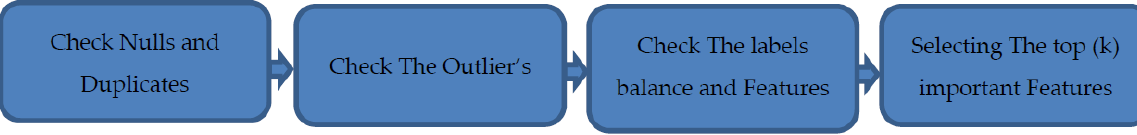
Figure 2. Data preprocessing pipeline.